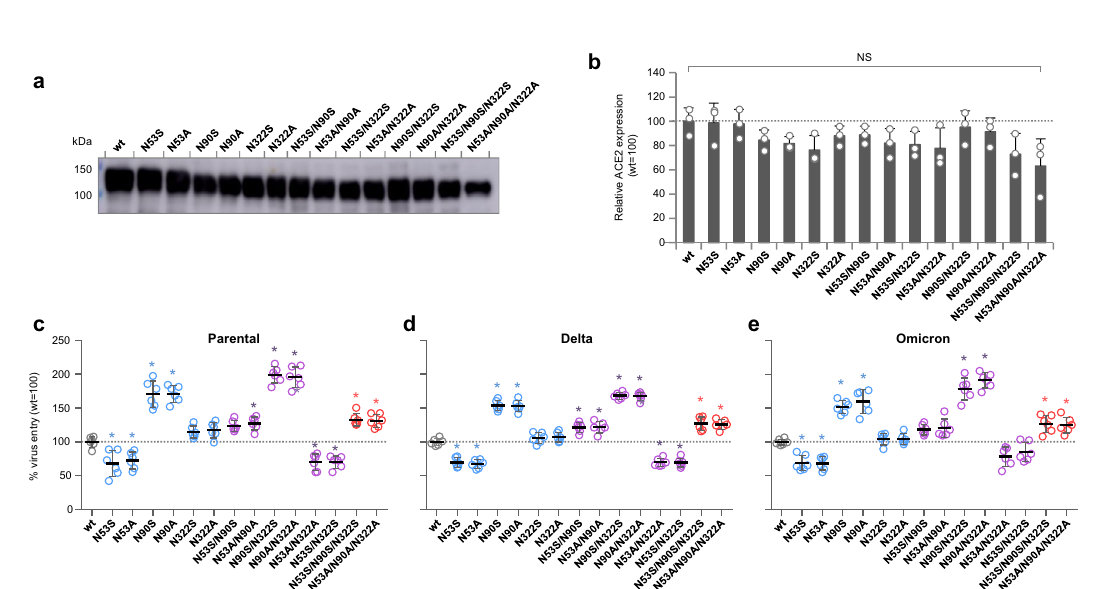
Fig. 3 Pro fi les of CoV 2 Parental, Delta and Omicron S-RBD binding to hACE2 glycan deletants. a – c Bio-layer interferometry binding analysis of the shACE2 glycan deletants to immobilized CoV2 Parental S-RBD ( a ), Delta S-RBD ( b ), and Omicron S-RBD ( b ). The experiments were repeated twice with different protein preparations and one representative set of curves is shown. Raw sensor grams and fi tting curves are shown in color and with dots, respectively. Three-fold serial dilutions from 3000 or 1000 nM hACE2 added on to the immobilized CoV2 RBD. d – f Summary of hACE2 variant binding pro fi les, K D ( d ), on-rate ( e ) and off-rate ( f ) to CoV2 Parental S-RBD, Delta S-RBD, and Omicron S-RBD. Kinetic data were globally fi tted with a 1:1 binding model with all binding curves that matched the theoretical fi t with R 2 > 0.95 and an average K D , off-rate and on-rate obtained from duplicates with different protein preparations are shown.